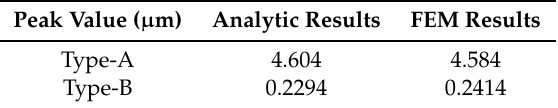
Table 7. The peak of the shock response in the analytic and FEM results.